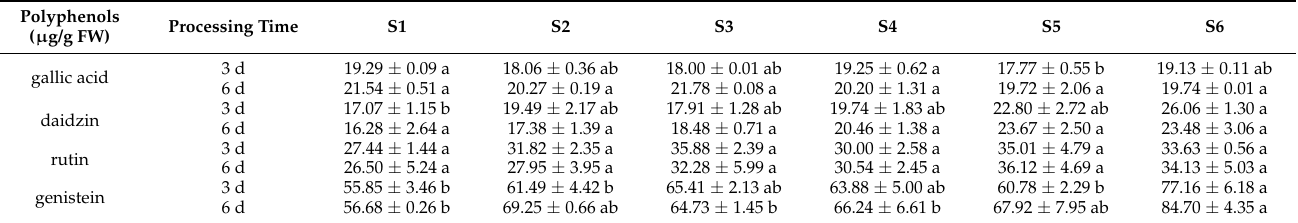
Table 3. The changes in the polyphenol fractions of soybean sprouts sprayed with different concen- trations of naringin after 3 and 6 days of storage, the unit is µ g/g FW. Three days: results of treatment after storage for three days; six days: results of treatment after storage for six days. Data (Means ± SD) followed by the different letter in the same line indicate statistically significant difference ( p <